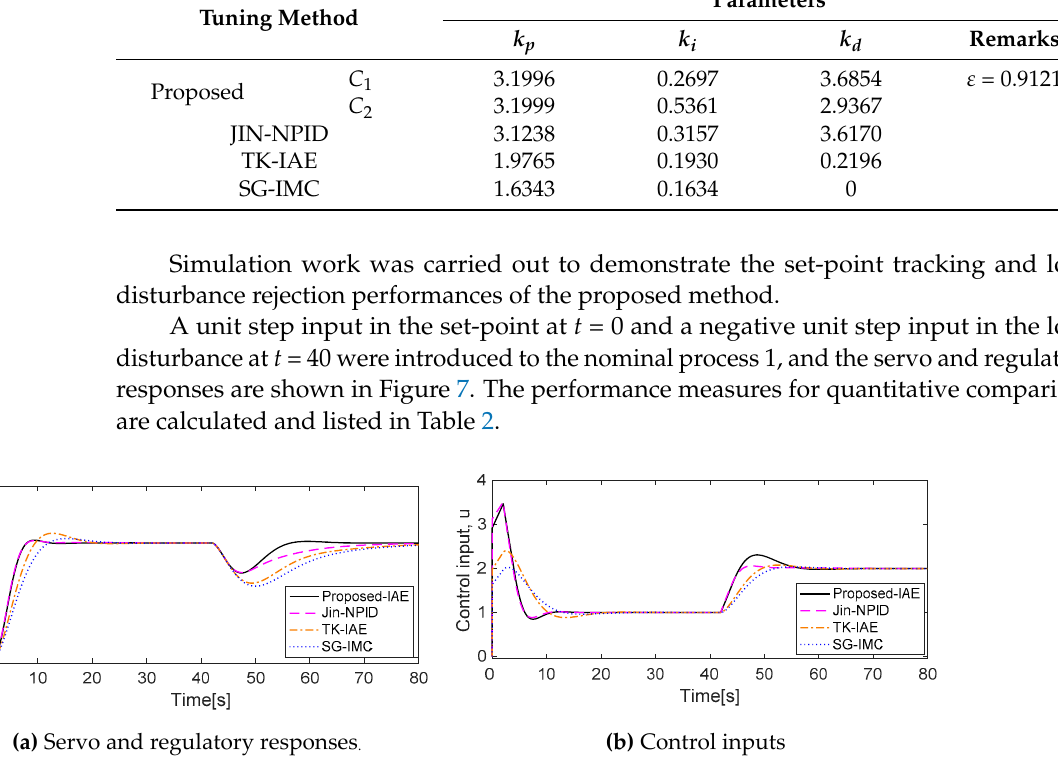
Figure 6. GA based evolutionary tuning of controllers C 1 and C 2 for process 1.